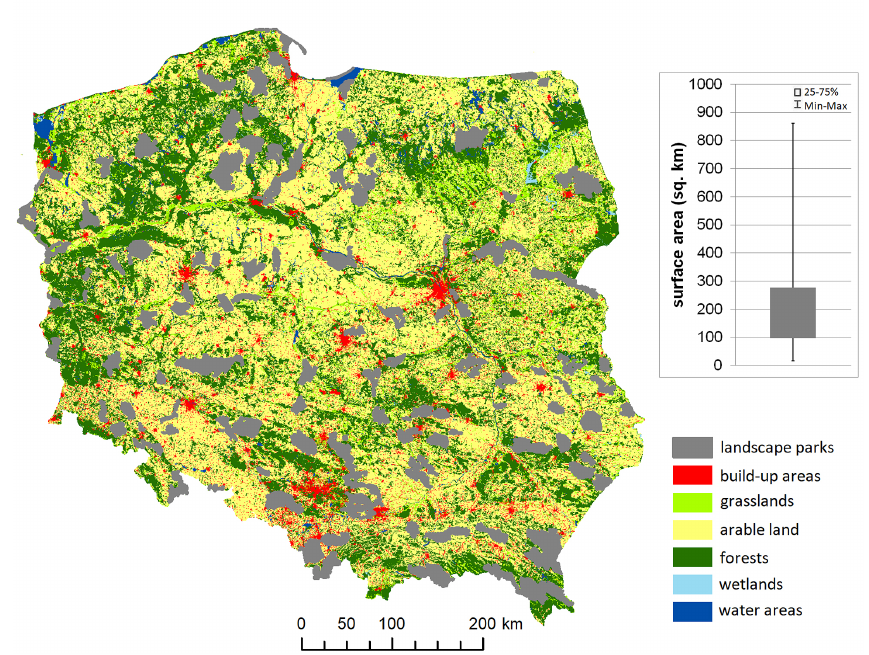
Fig. 1. The location of landscape parks on the background of Poland’s land